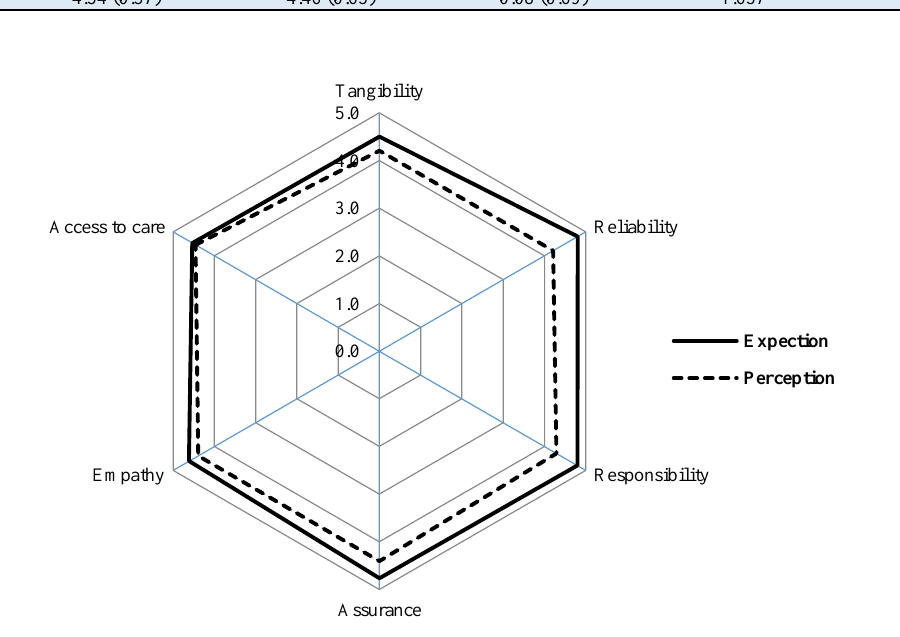
Figure 1. Expectation – Perception Gap Analysis (SERVQUAL dimensions)